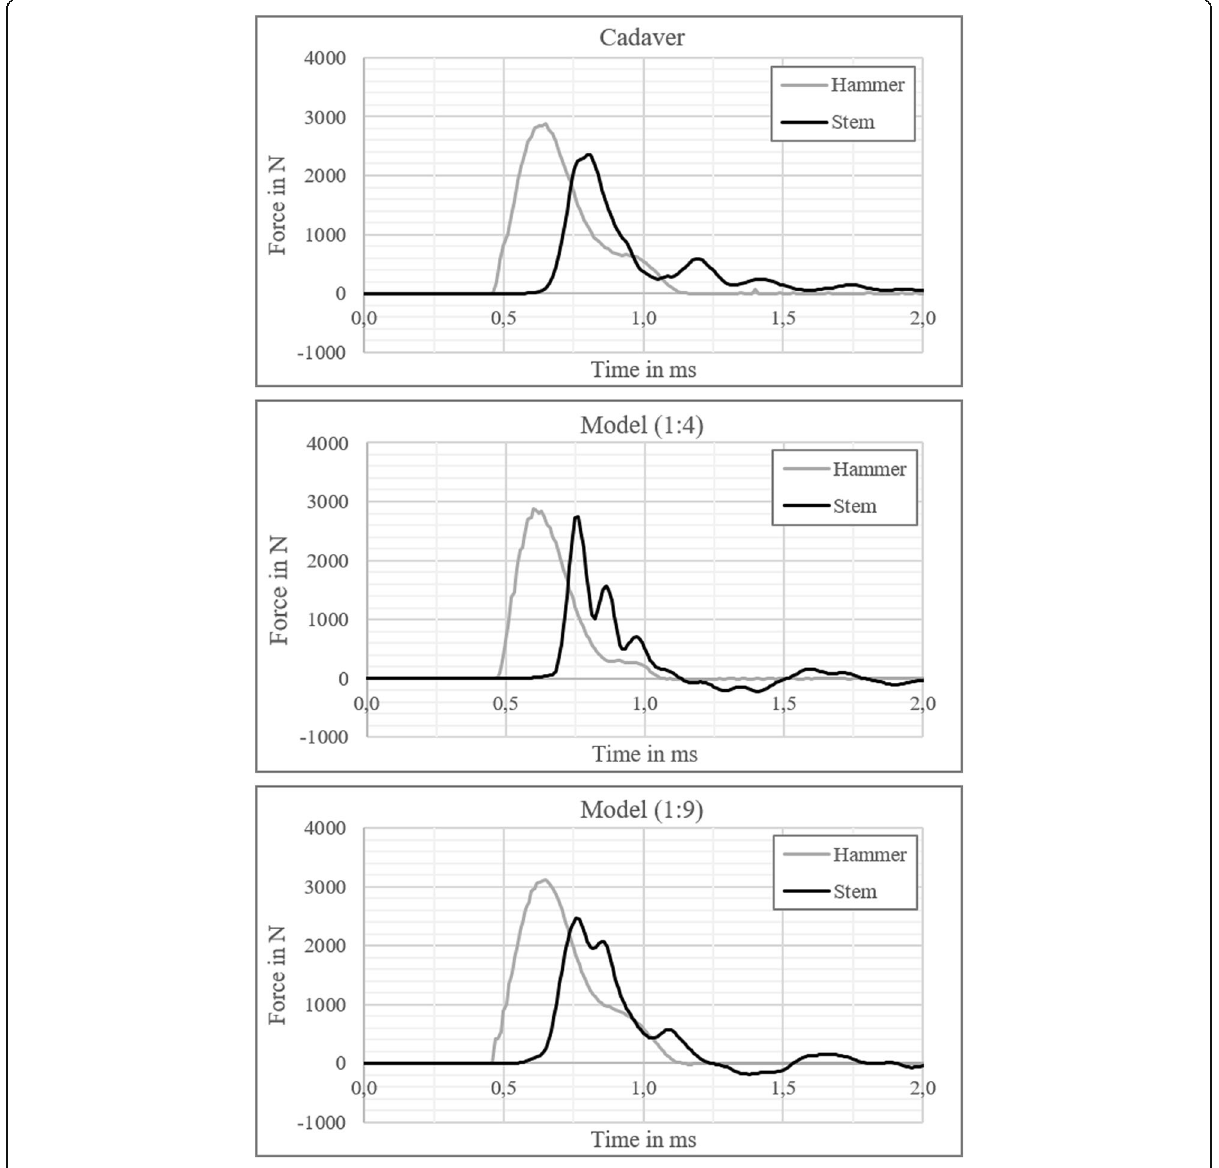
Fig. 7 Exemplary force curves measured on ( a ) cadavers and on in vitro models with gelatine mixing ratios of ( b ) 1:4 and ( c )